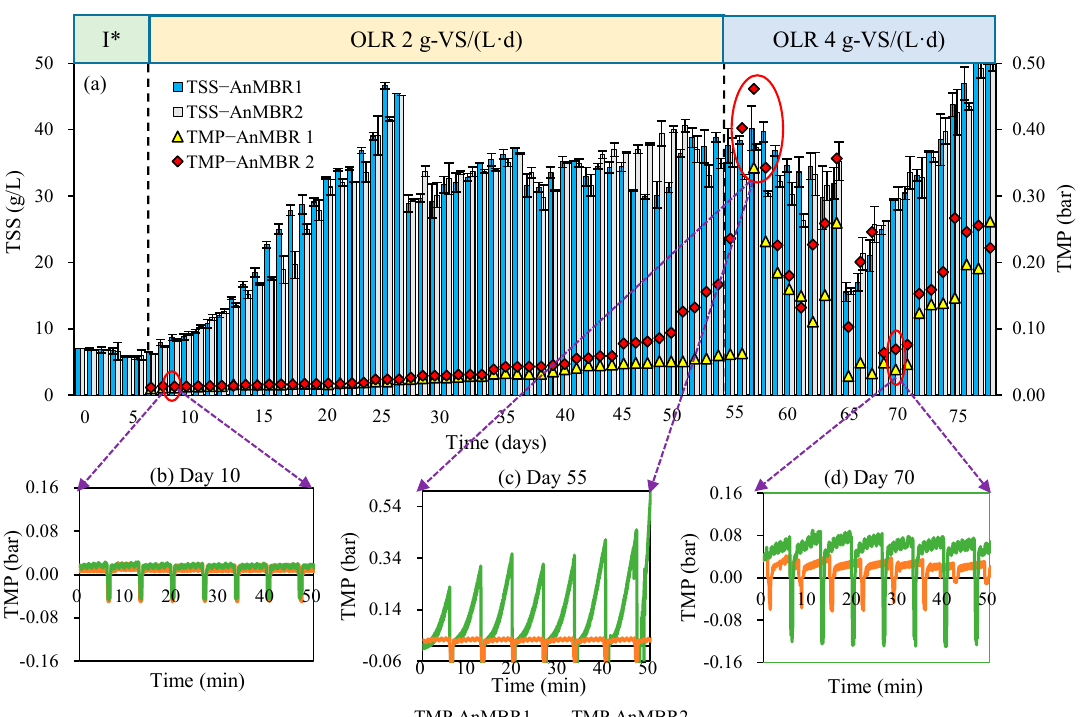
Figure 5. ( a ) Changes in the TMP and TSS during fermentation and filtration in the AnMBRs and the TMP at ( b ) day 10, ( c ) day 55, and ( d ) day 70. I* represents the start-up stage.